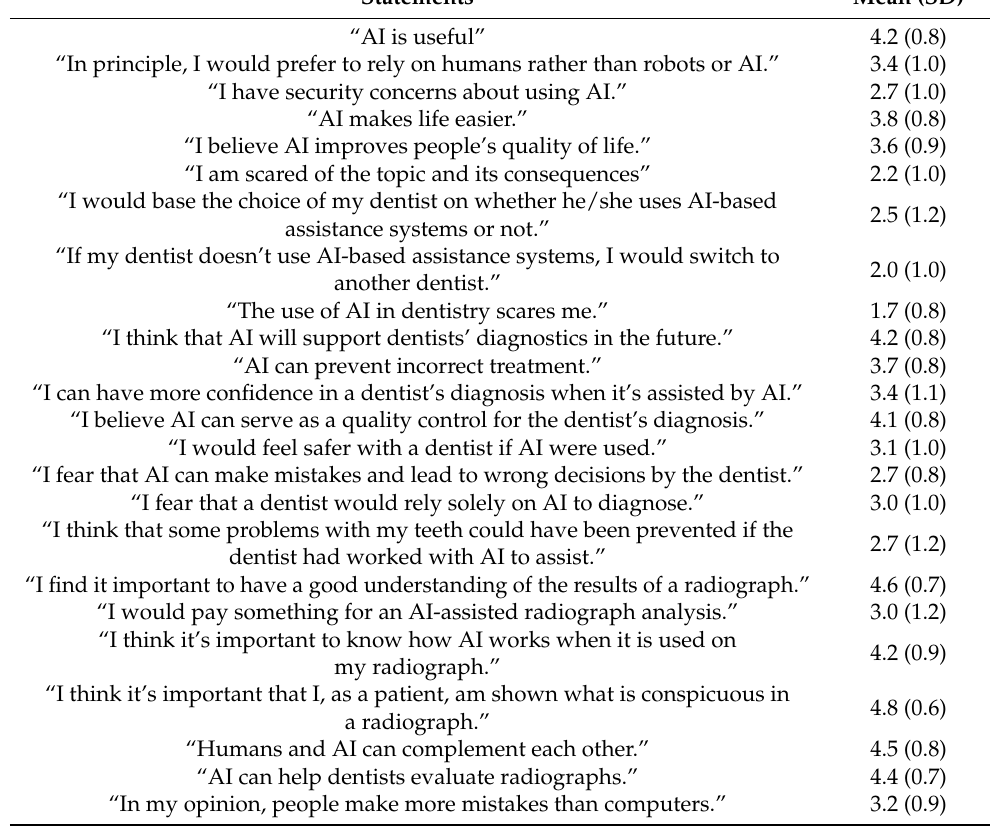
Table 2. Descriptive analysis of patients’ attitudes towards AI and, specifically, its application in dentistry. The mean (standard deviation) Likert-scale values (from 1—strongly disagree to 5—strongly agree) are